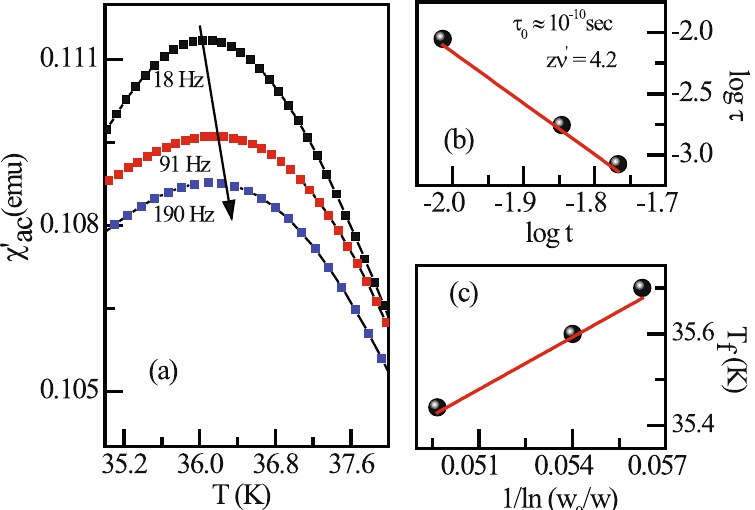
Figure 6. ( a ) The temperature dependence of the real parts of the ac magnetic susceptibility of Sm 0.4 Ca 0.6 MnO 3 compound measured at different frequencies in an applied ac magnetic field of 3 Oe. ( b ) The frequency dependence of freezing temperature plotted as a log( τ ) vs . log(t). ( c ) The frequency dependence of freezing temperature plotted as T f vs . 1/ln( ω 0 / ω